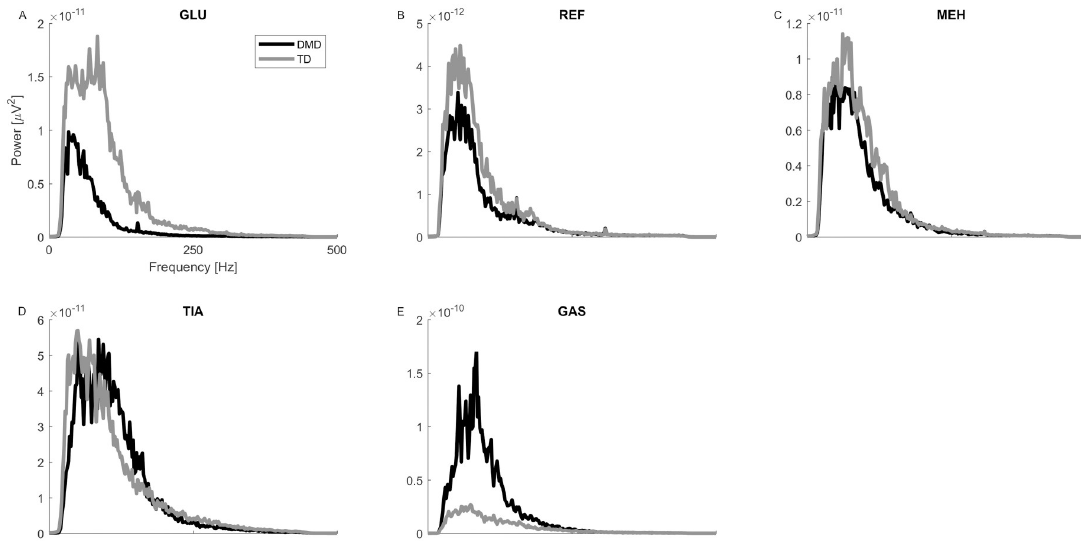
Fig 3. Power spectrum density plots of filtered sEMG signals (20–450 Hz). (A-E) show the median curves of the GLU (A), REF (B), MEH (C), TIA (D) and GAS (E) for the children with DMD (black) and the TD children (grey). Abbreviations in alphabetic order: DMD = Duchenne muscular dystrophy; GAS = gastrocnemius; GLU = gluteus medius; Hz = Hertz; MEH = medial hamstrings; REF = rectus femoris; TD = typically developing; TIA = tibialis anterior; μ V = microvolts.